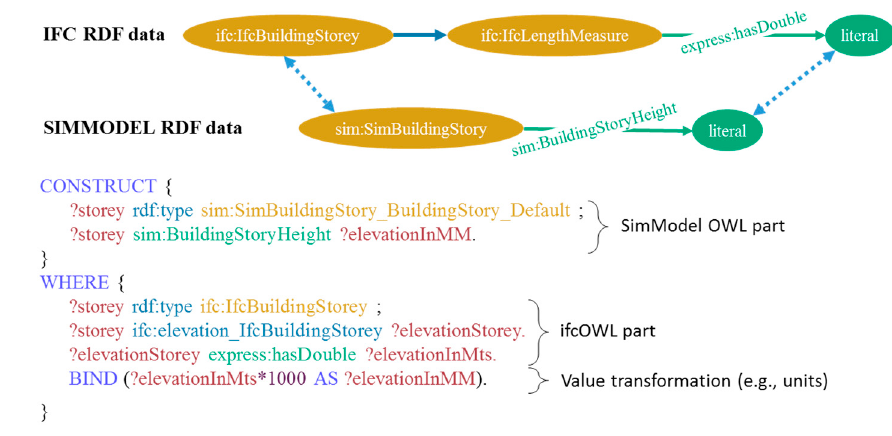
Figure 2. Example of overcoming semantic and structural